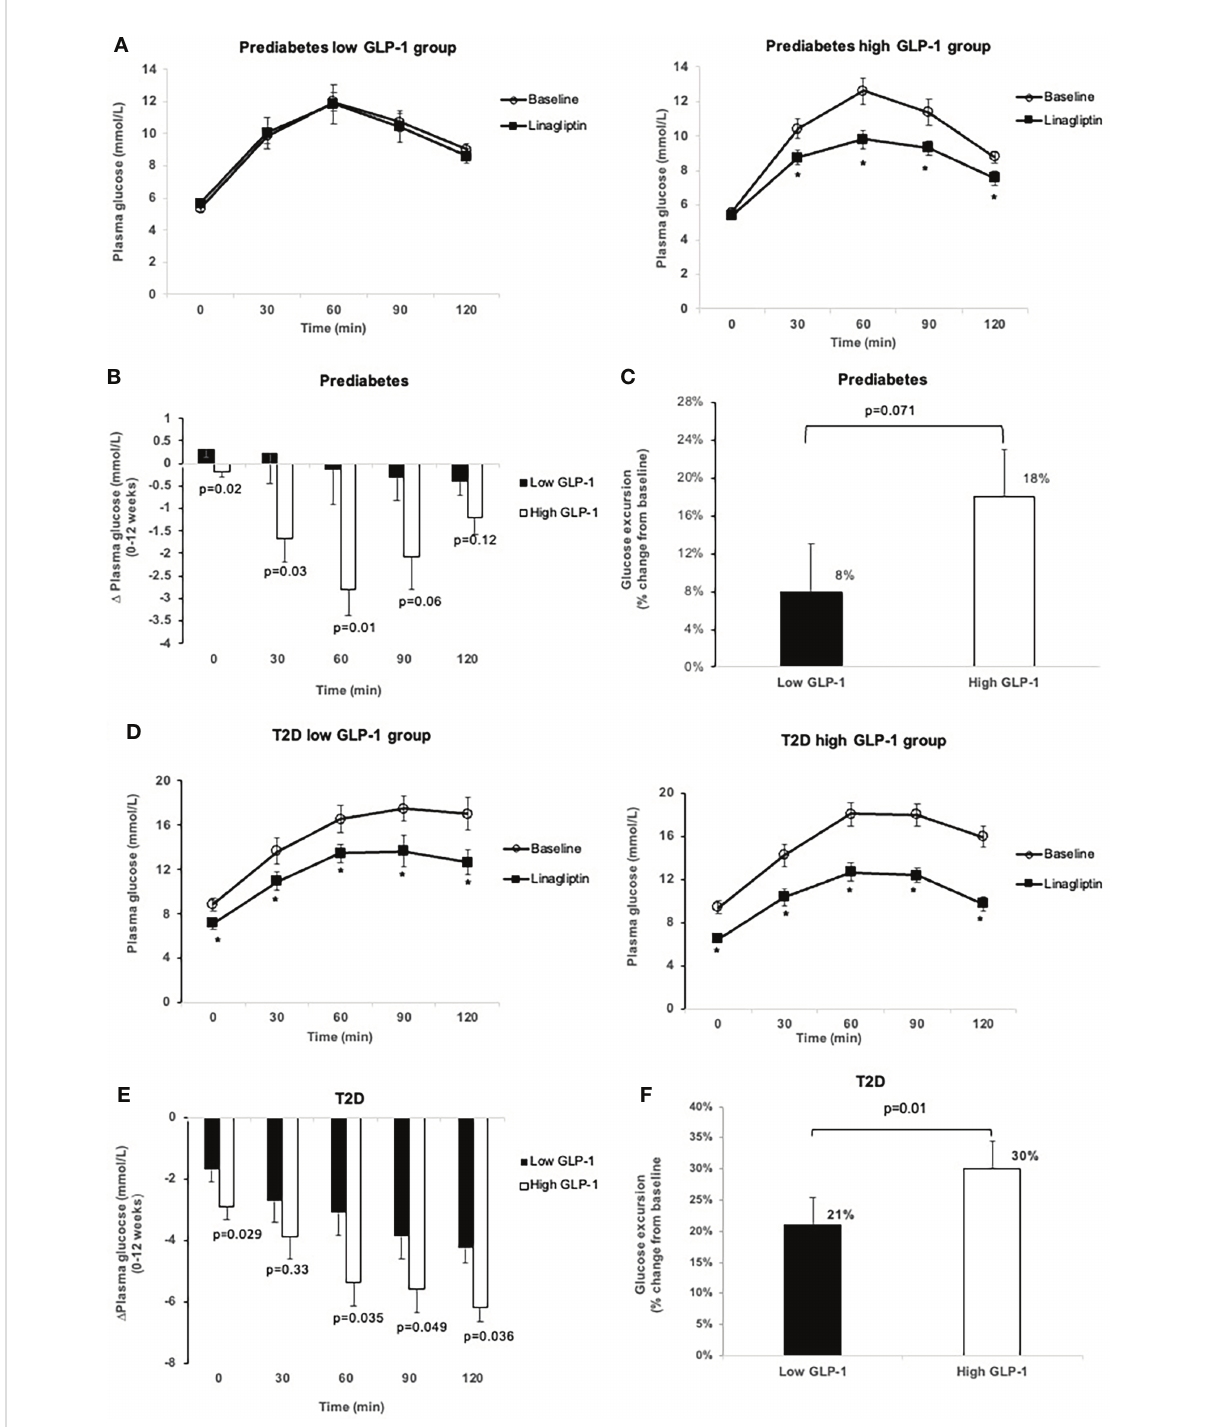
FIGURE 2 Comparison of glucose levels during OGTT at baseline and after 12-week treatment with linagliptin in low GLP-1 and high GLP-1 groups in prediabetes and T2D: glucose levels in prediabetes (A) ; change in glucose levels from 0 to 12 weeks in prediabetes (B) ; glucose excursion in prediabetes (C) ; glucose levels in T2D (D) ; change in glucose levels from 0-12 weeks in T2D (E) ; glucose excursion in T2D (F) . White circles: baseline; black squares: after linagliptin treatment; black bars: low GLP-1 group; white bars: high GLP-1 groups. T2D, type 2 diabetes. *p<0.05. Data shown are mean ± standard